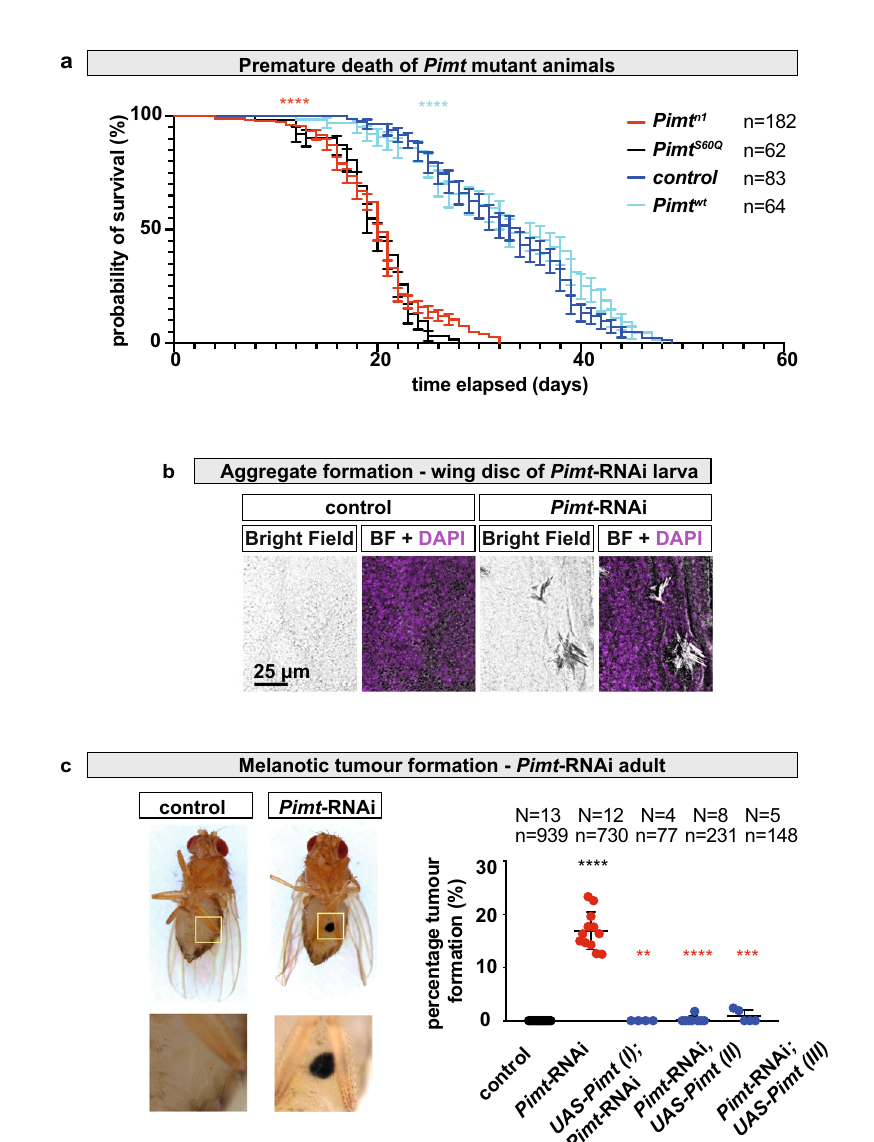
Fig.5|Lossofhomochiralityreduceslifespan.a Prematuredeathof Pimt n1 knock- out null mutant animals is rescued by Pimt knock-in wild type ( Pimt wt ) but not by Pimt knock-in S60Q ( catalytic dead, CD, Pimt S60Q ) construct. Median survivals in